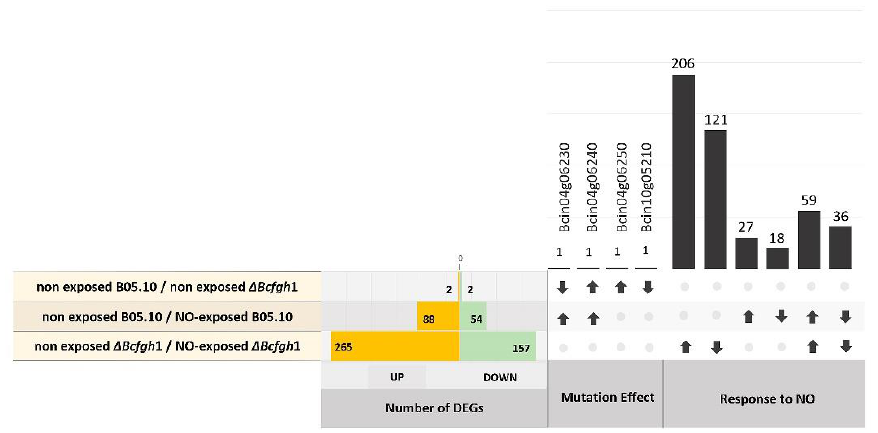
Figure 7. Summary of the DEGs detected in the differential gene expression analysis in response to NO in the B05.10 and Δ Bcfhg 1 strains.